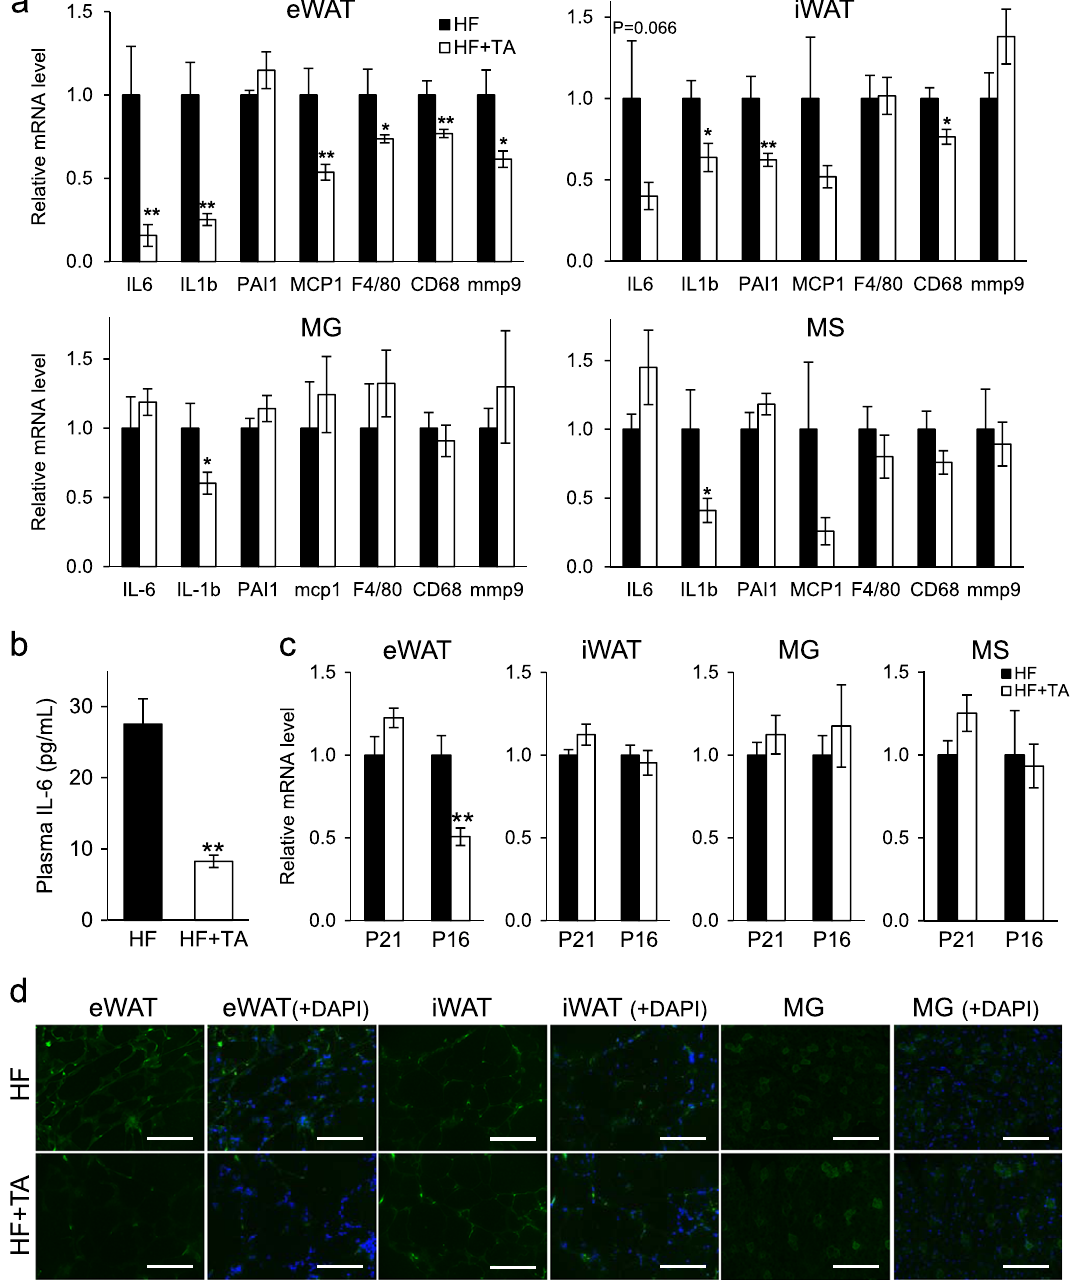
Fig. 3 Expression of in fl ammatory and senescence markers in TA-1887-treated db/db mice fed a high-fat diet. a mRNA levels of in fl ammatory mediators in eWAT, iWAT, MG and MS after 4 months of indicated treatment ( n = 5-9). b Plasma IL-6 concentration after 2 months of drug treatment, as determined by ELISA ( n = 8). c mRNA levels of the senescence markers p21 and p16 INK4a in eWAT, iWAT, MG and MS after 4 months of indicated treatment ( n = 5 – 9). d Senescence-associated staining for SPiDER beta-Gal in frozen sections of eWAT, iWAT and MG tissues after 4 months of treatment. Scale bars: 200 μ m. IL-6, interleukin-6; IL-1b, interleukin-1b; PAI-1, plasminogen activator inhibitor-1; MCP1, monocyte chemoattractant protein-1; mmp9, matrix metalloproteinase 9. Values shown are means ± SEM. * p < 0.05 and ** p < 0.01 versus